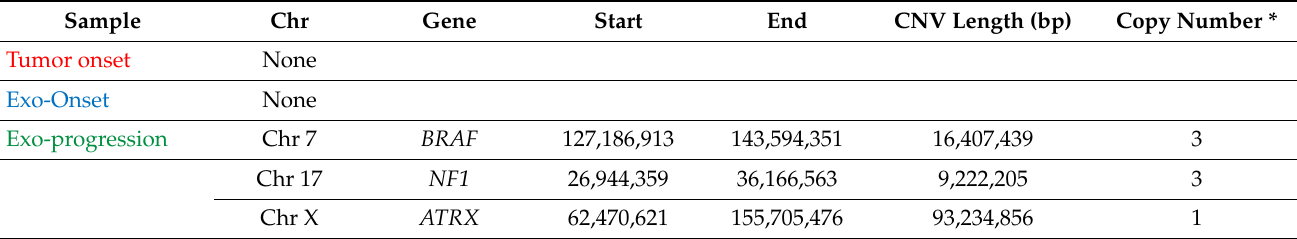
Table 2. Genes displaying copy number variations (CNVs).